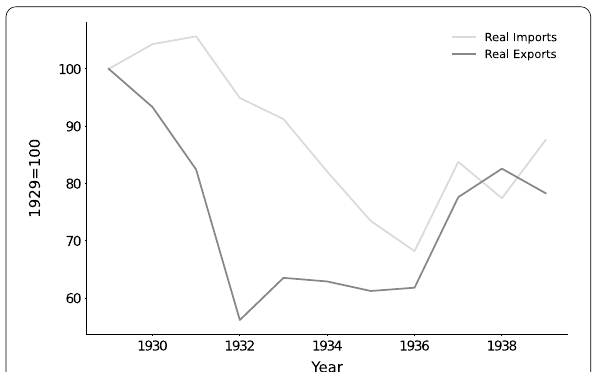
Fig. 1 Real Exports and Imports of Switzerland, 1929–1939 (1929 100). Data Source : SNB